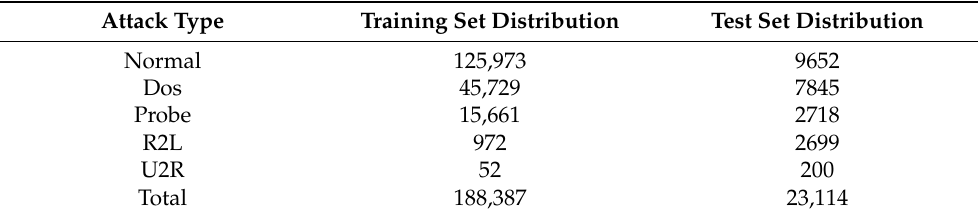
Table 1. NSL-KDD data distribution. Attack Type Training Set